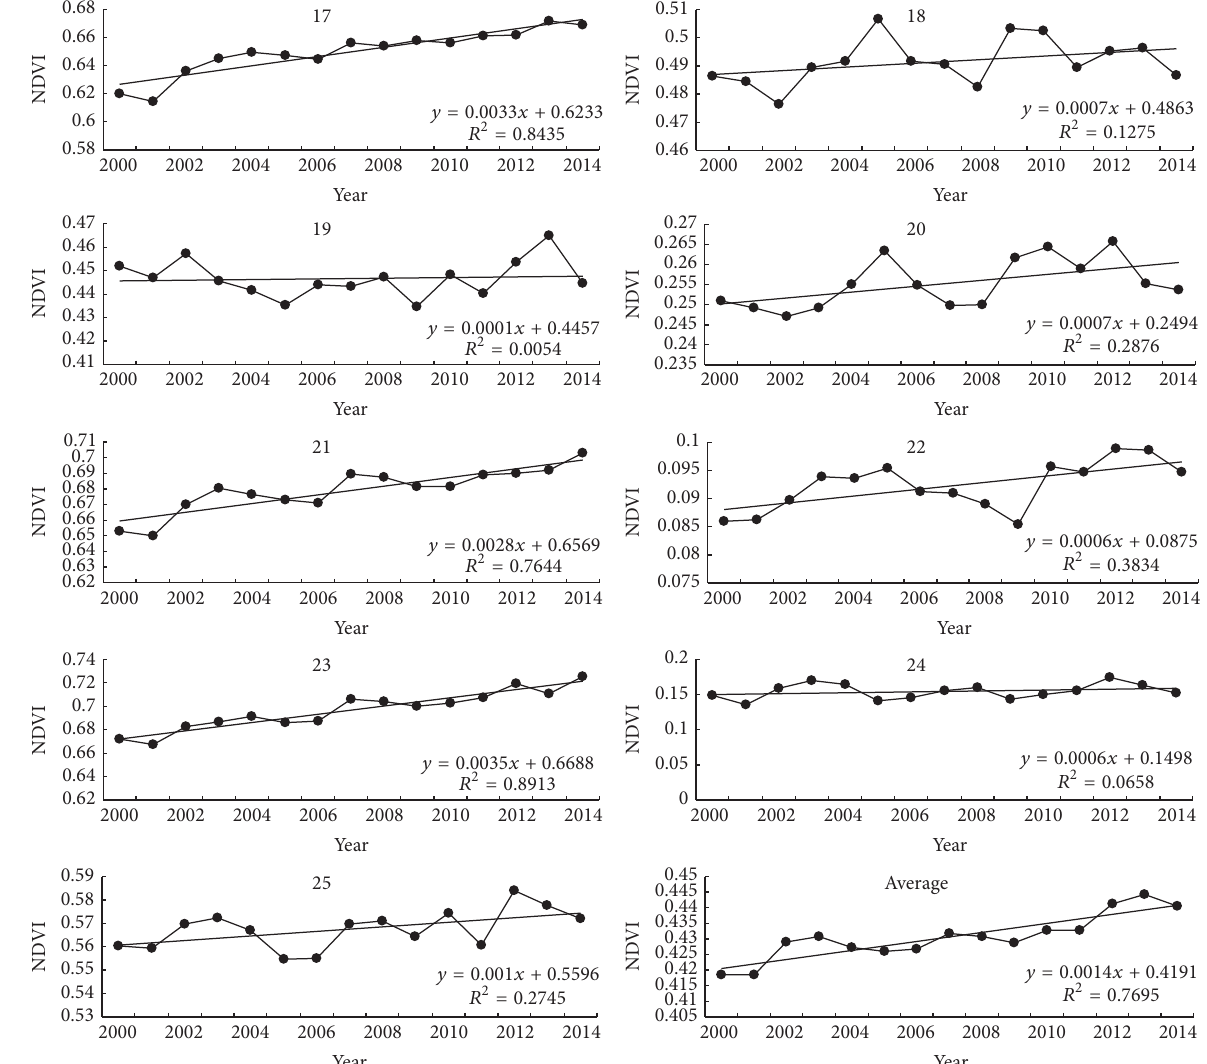
Figure 5: Statistic features of mean values of NDVI in NKEFZ from 2000 to 2014.